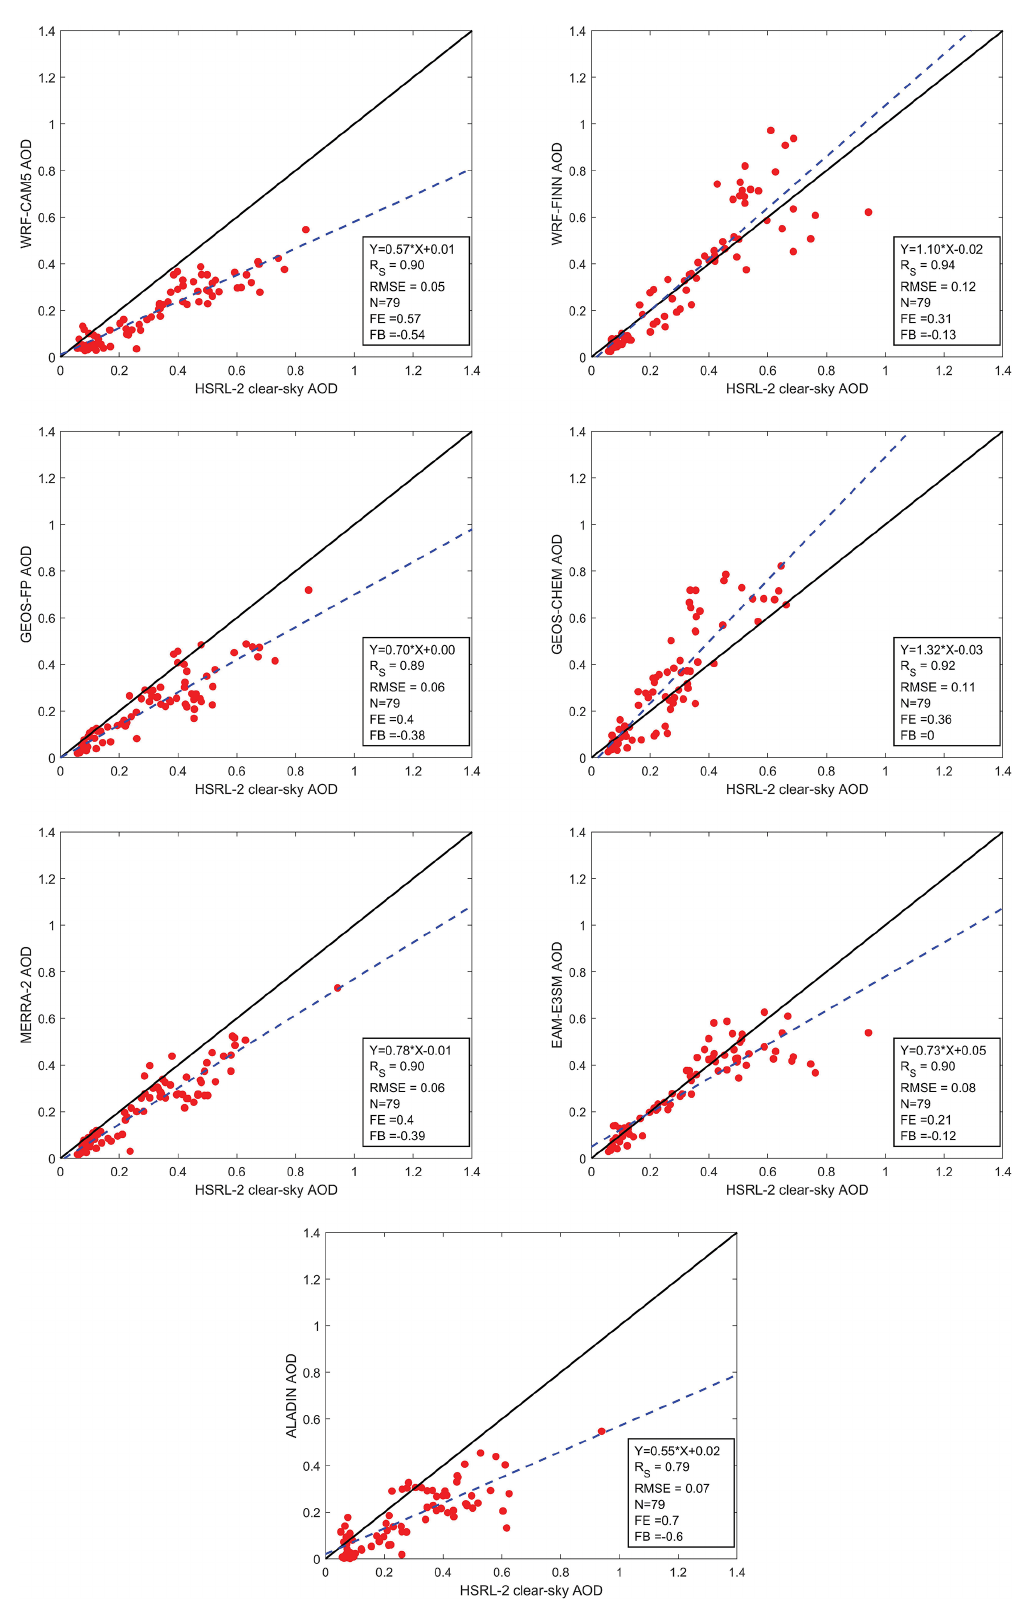
Figure 10. Scatterplots comparing full-column AOD (at 550nm) from the models to HSRL-2 clear-sky AOD during the September 2016 deployment of the ORACLES field experiment. An ordinary least-squares fit (dashed blue lines) is used to estimate the linear fit. Atmos. Chem. Phys., 23, 4283–4309, 2023